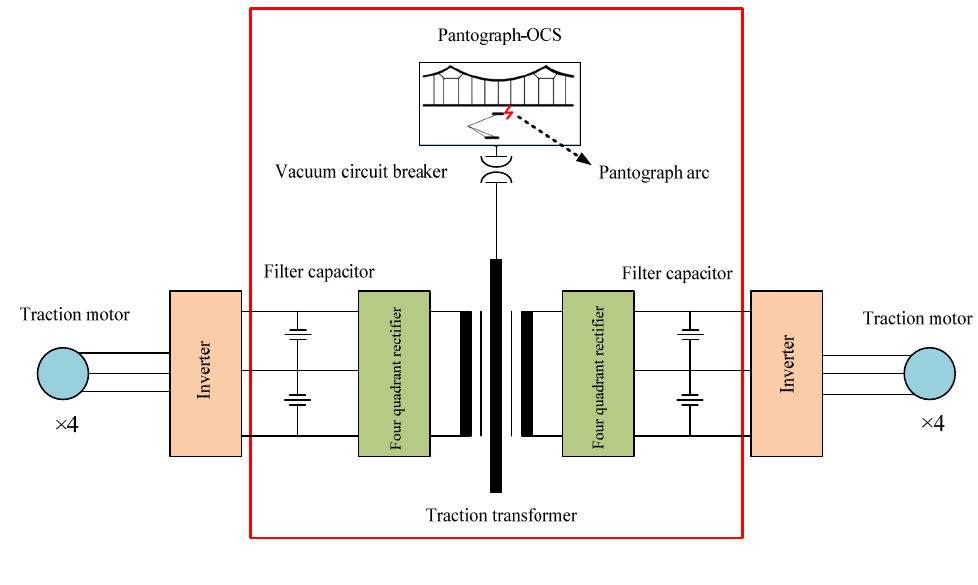
Figure 1. Traction drive system of a high speed